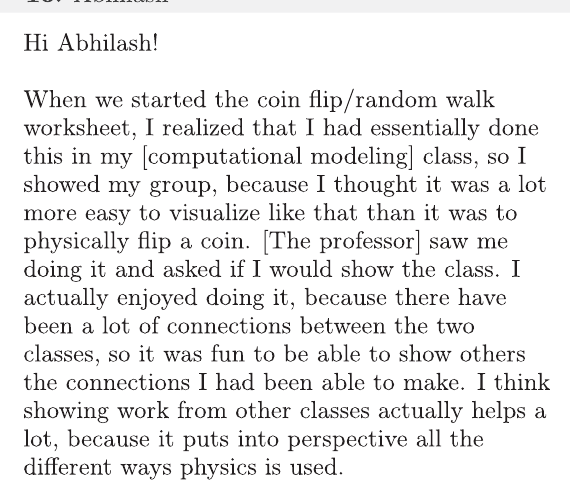
FIG. 6. An email exchange between A. N. and Nicole shortly after she presented a simulation she had made for her computa- tional modeling